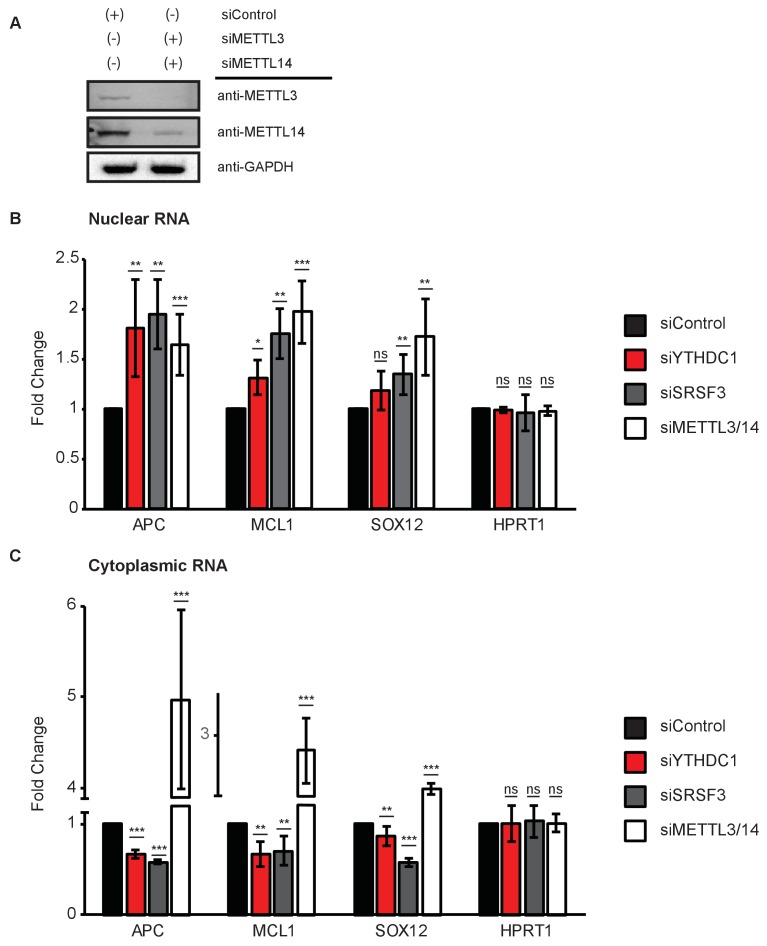
Subcellular distribution of YTHDC1 target mRNAs as a function of YTHDC1, SRSF3, and m6A.(A) Representative western blot for simultaneous siRNA knockdown of METTL3 and METTL14 in HeLa cells. (B) RT-PCR of nuclear RNA following knockdown of YTHDC1, SRSF3, and METTL3/14 in HeLa cells. Error bars represent mean ± standard deviation, n = 4, *p<0.05, **p<0.01, ***p<0.001, two-sided t-test with equal variance. (C) RT-PCR of cytoplasmic RNA following knockdown of YTHDC1, SRSF3, and METTL3/14 in HeLa cells. Error bars represent mean ± standard deviation, n = 4, *p<0.05, **p<0.01, ***p<0.001, two-sided t-test with equal variance.10.7554/eLife.31311.024Figure 5—figure supplement 4—source data 1.Subcellular distribution of YTHDC1 target mRNAs as a function of YTHDC1, SRSF3, and m6A.